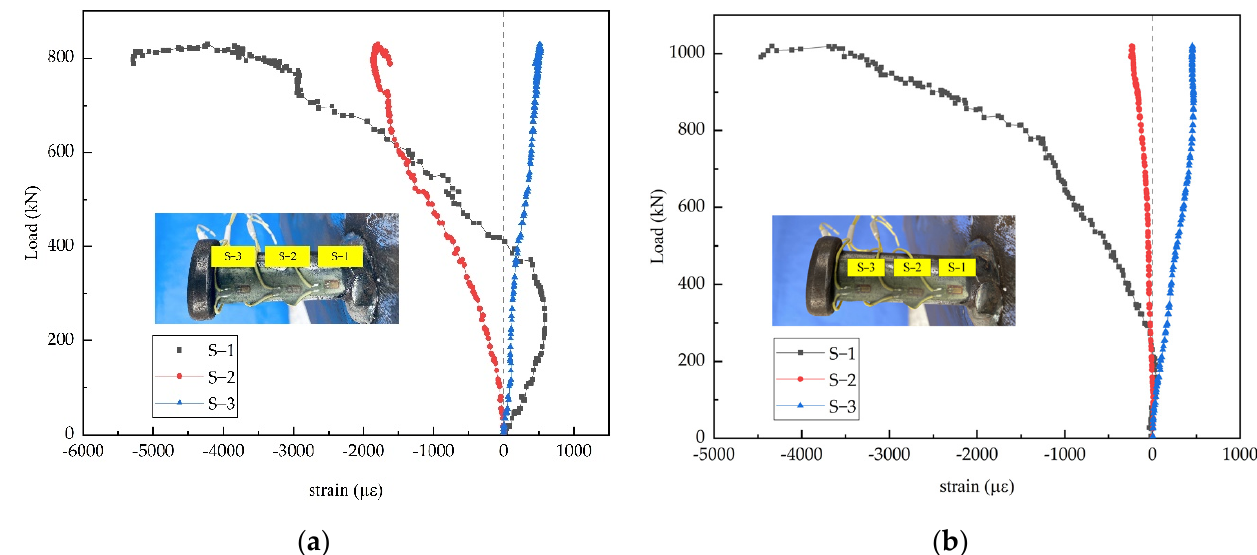
Figure 7. Load-strain relationship of studs: ( a ) N-120-22; ( b ) S-120-22.